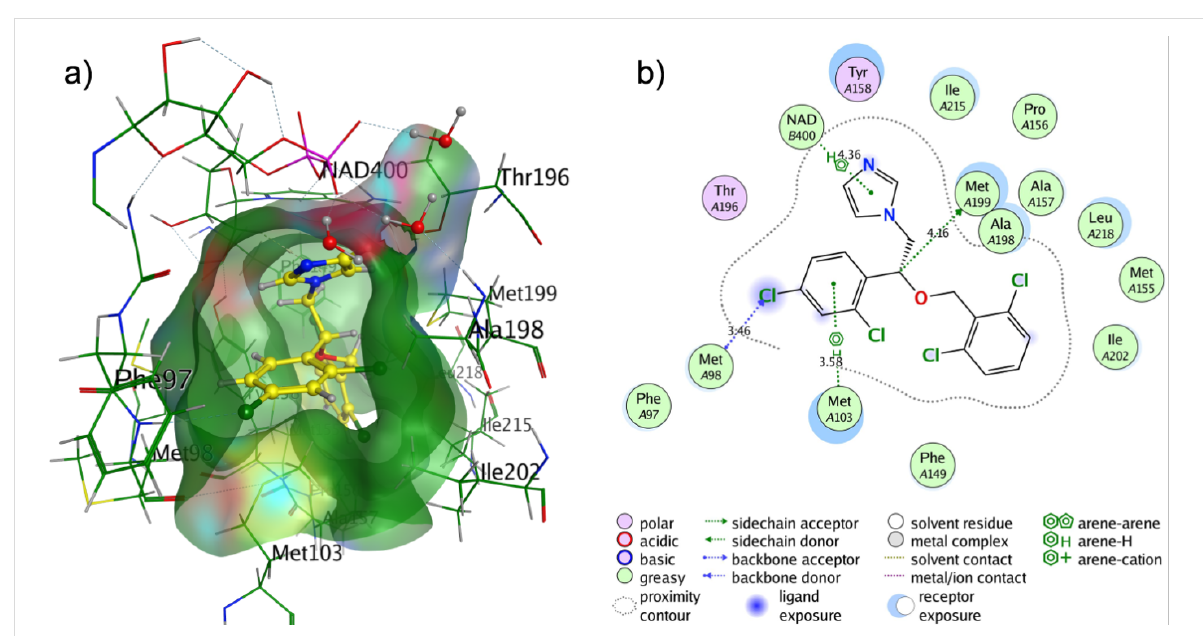
Figure 12: 3D (left) and 2D (right) representation of the isoconazole docking pose in the active site of InhA (PDB code: 4U0J).